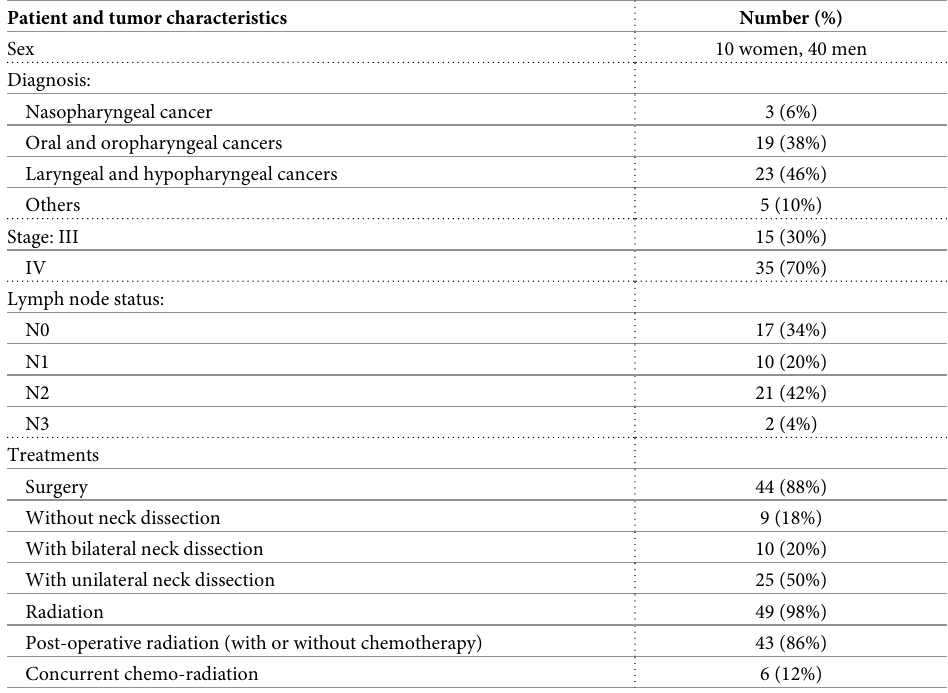
Table 1. Characteristics of patients with cancer.